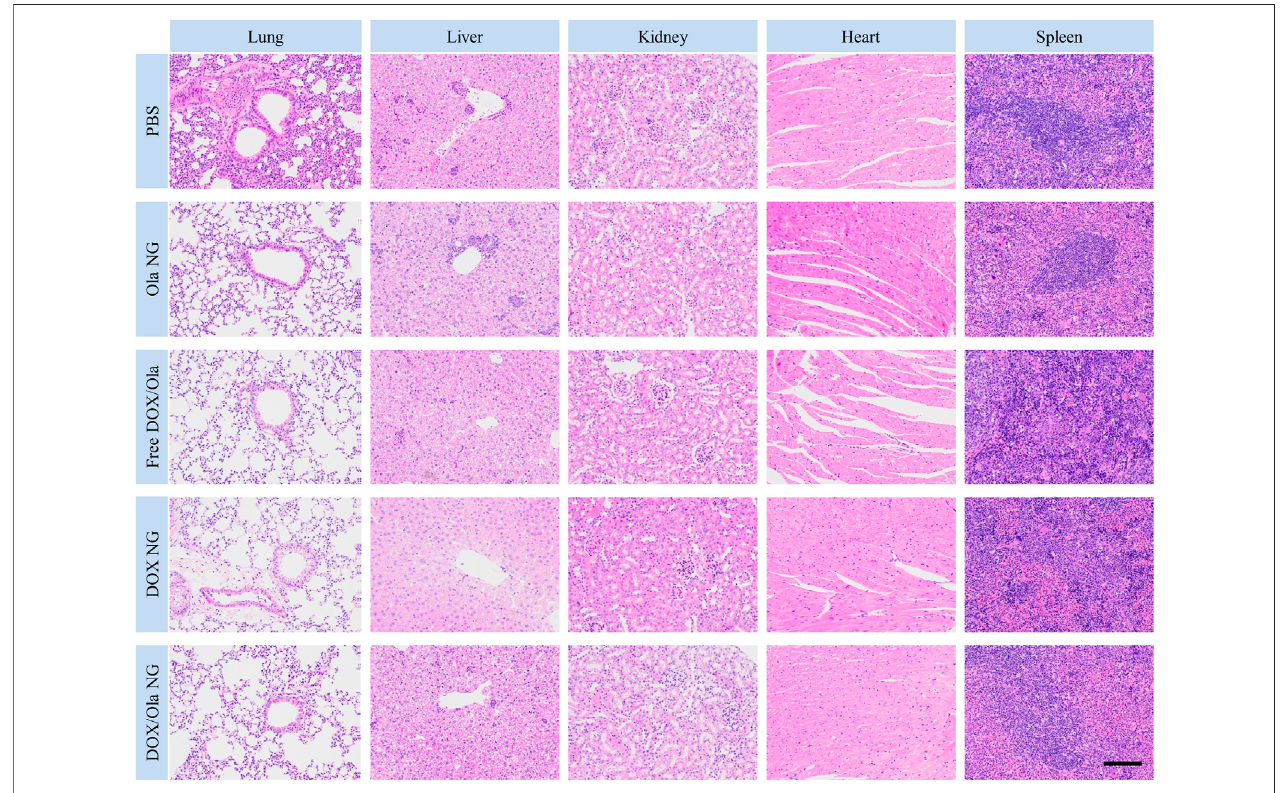
FIGURE 8 | H&E staining of lung, liver, kidney, heart, and spleen specimens after treatment. The scale bar is 100 μ